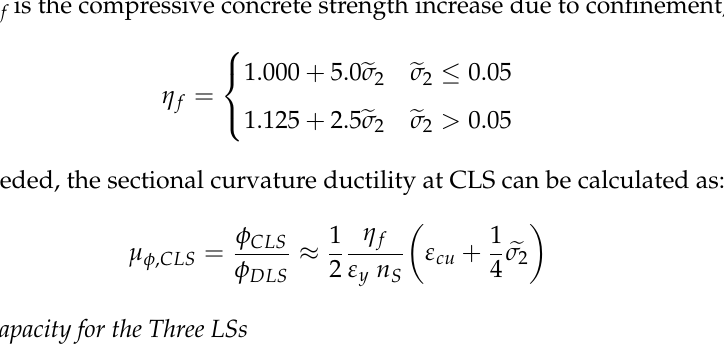
Figure 3. Cross-section with geometric parameters: 𝑑 is the section depth, 𝑏 is the section width, 𝑏 𝑥 is the concrete core width, 𝑏 𝑦 = 𝑑 𝑐 is the section depth at collapse, 𝐴 𝑠 is the tension steel area (equal to that in compression), 𝐴 𝑠𝑤 is the stirrup area, and 𝑠 is the stirrup spacing.